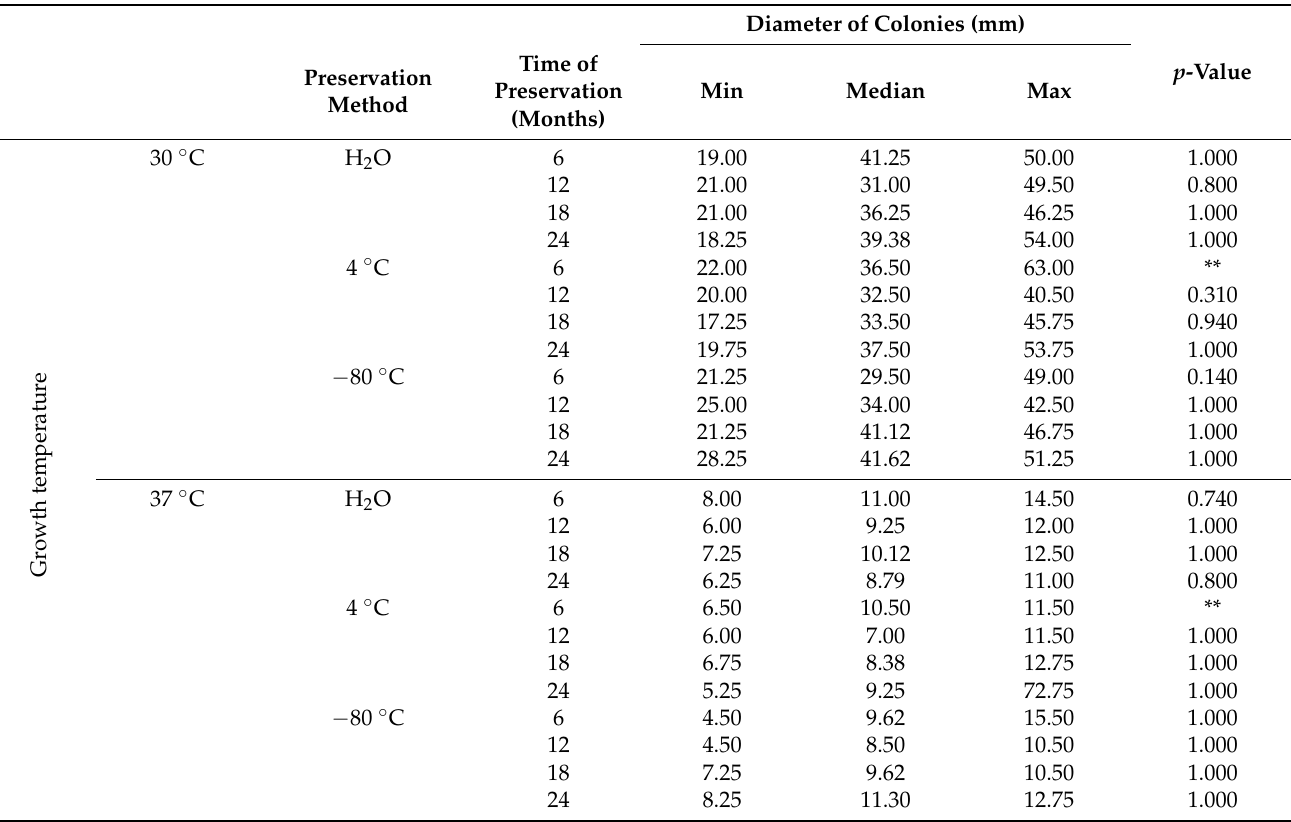
p -ValuePreservation